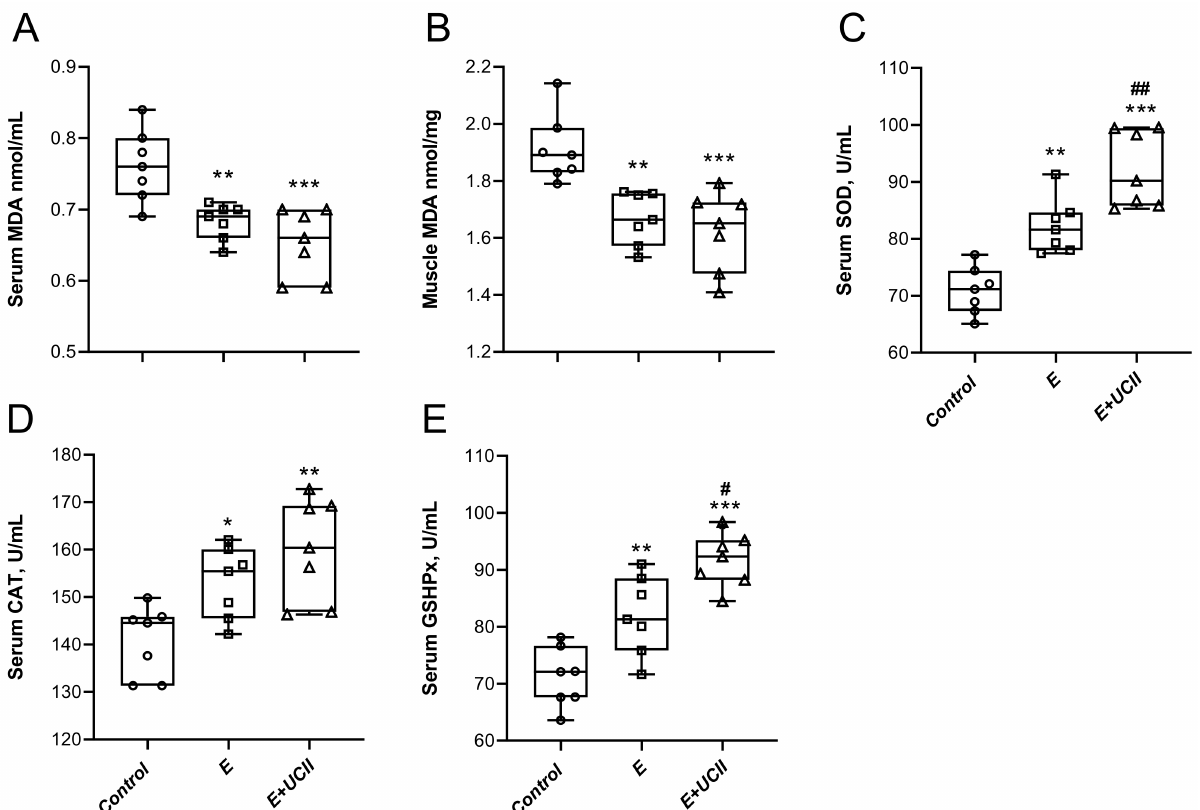
Figure 3. The effects of UCII on the serum MDA ( A ), muscle MDA ( B ), serum SOD ( C ), CAT ( D ), and GSHPx ( E ) levels in exercised rats. Box and Whisker plots show median, min, and max values. ANOVA and Tukey’s post-hoc test were used to compare the results among different treatment groups. Statistical significance between groups is shown by: * p < 0.05, ** p < 0.01, *** p < 0.001 compared as control group and # p < 0.05, ## p < 0.01 compared as exercise Group. UCII, Undenatured type II collagen; MDA, malondialdehyde; SOD, superoxide dismutase, CAT, catalase; GSHPx, glutathione peroxidase, Control (Circle): no exercise and no UCII, E (Square): exercised rats, E + UCII (triangle), exercised rats receiving 4 mg/kg BW/day